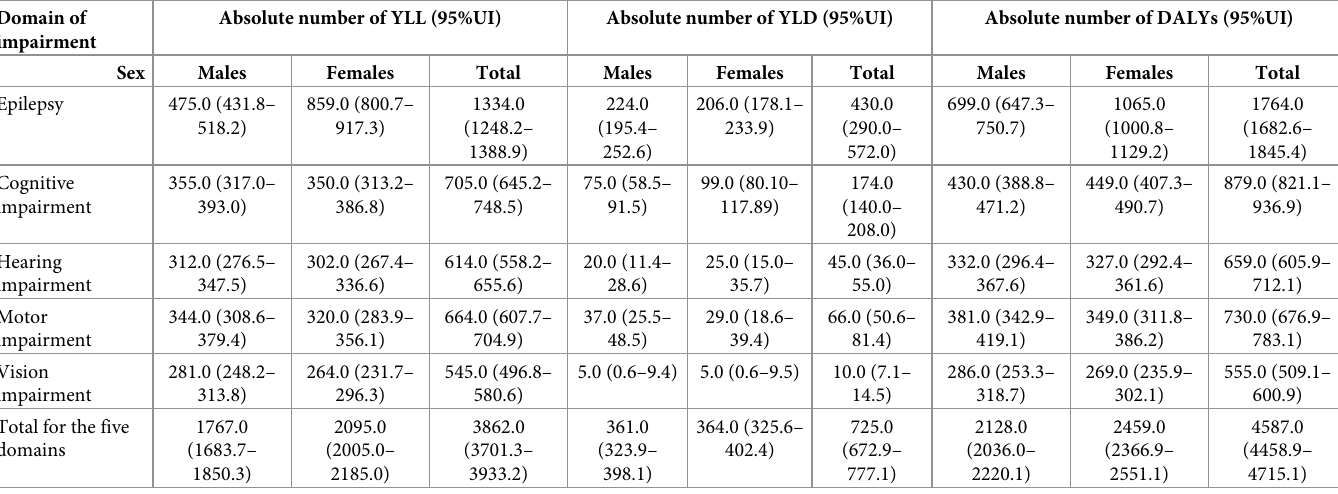
Table 2. Absolute estimates of YLL, YLDs, and DALYs (95% Uncertainty Intervals) classified by sex and NI domain for children aged 5–14 years in Kilifi, Kenya. Domain of impairment